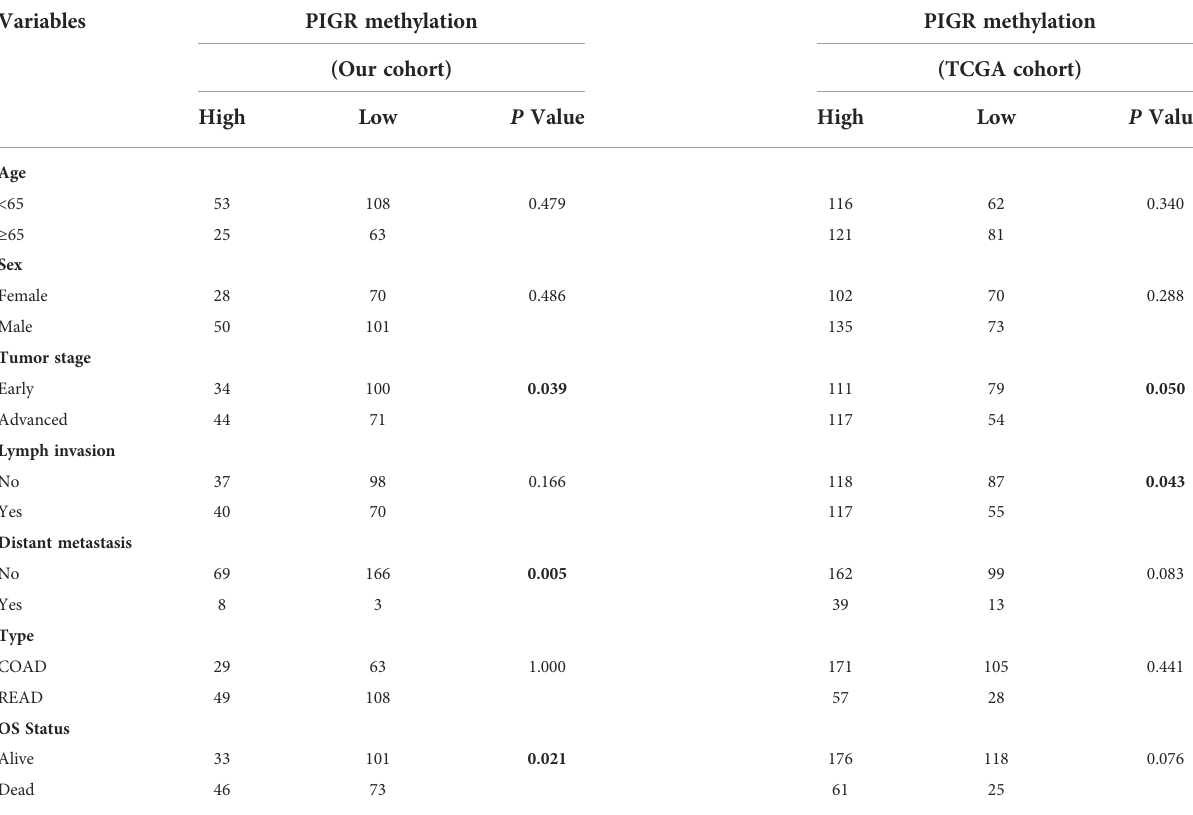
TABLE 1 Association between PIGR methylation and clinicopathological features in CRC patients of our cohort and TCGA cohort.